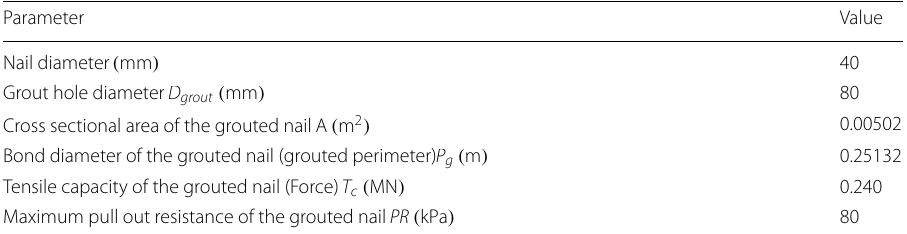
Table 2 Parameters used in LEM modelisation